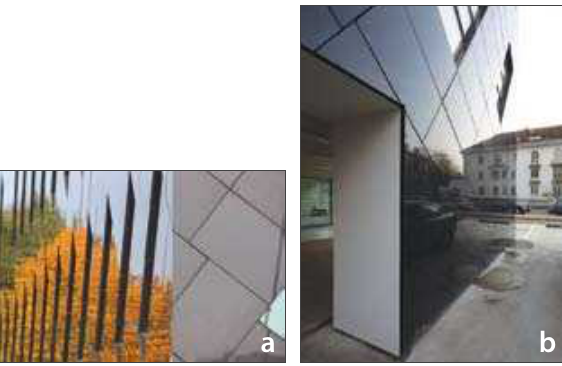
18 pav. Prokuratūrų pastatas (atspindžiai) (a, b), Vilnius. archit. k. Lupeikis, 2008 m. Fig. 18. Prosecutor's Office building (reflections) (a, b), Vilnius. arch. k. Lupeikis, 2008.